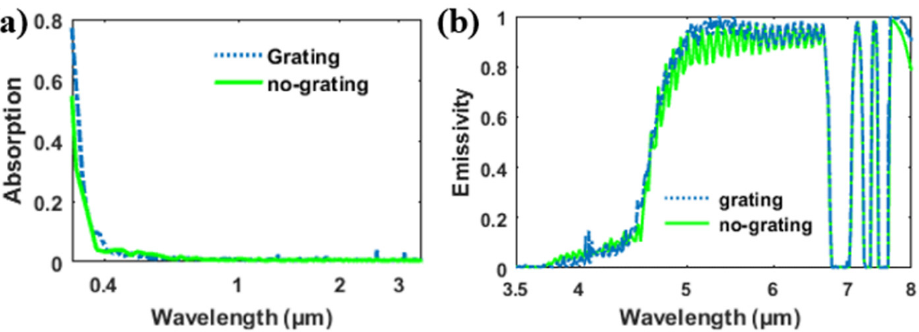
Figure 6. Absorption/emissivity for the proposed structure with/without the grating at ( a ) 0–3.7 µ m and ( b ) 3.5–8 μ m.